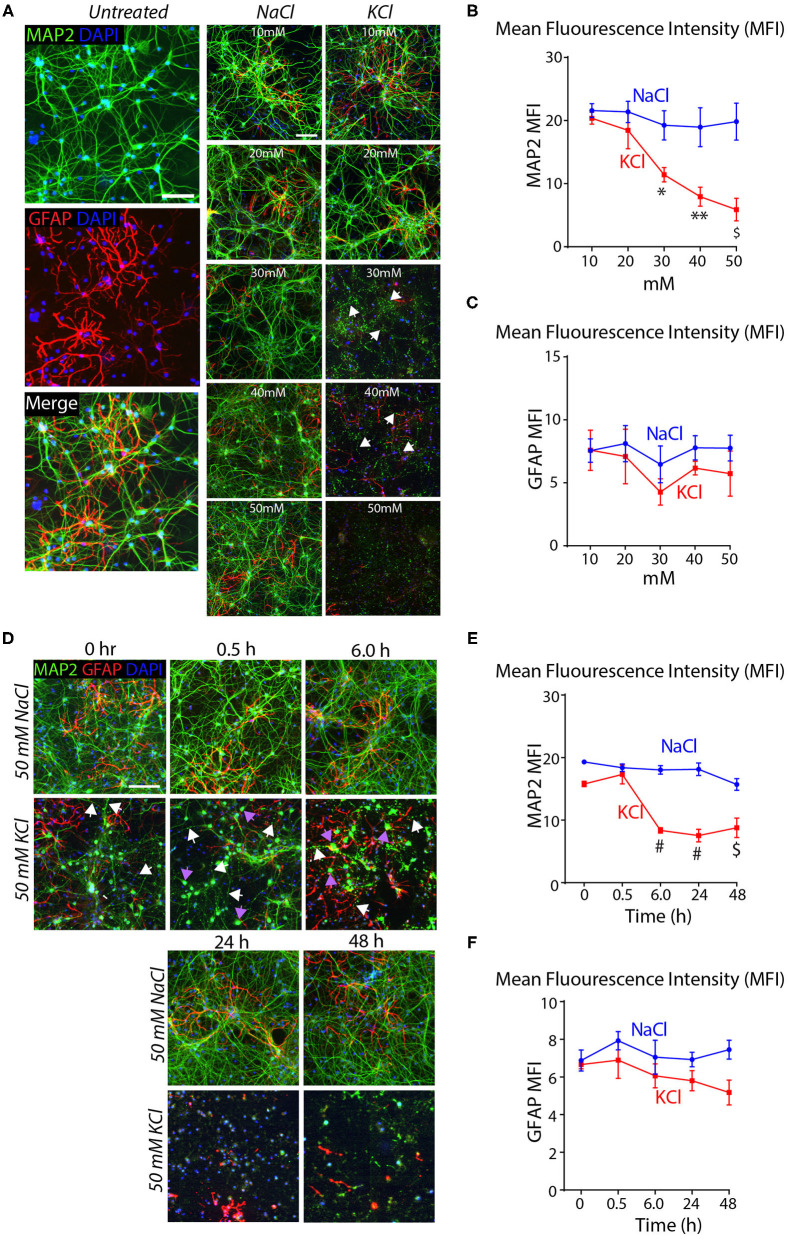
High KCl exposure in cultured cortical neurons leads to reduction in MAP2 protein expression marked by dendritic breakage followed by neuronal death. (A) Representative microscopic images of NaCl and KCl treated neurons at different concentrations show remarkable reduction in MAP2 levels from 30 mM KCl and almost no signal at 50 mM. Arrows indicate dendritic breakage. GFAP levels remains the stable across all concentration of KCl and NaCl. Untreated cells shown for comparison. (B,C) Quantification of mean fluorescence intensity (MFI) of MAP2 and GFAP immunofluorescence show gradual and significant reduction in MAP2 levels from 30 to 50 mM to KCl compared to NaCl treated cells. (* = p 0.0225, ** = p 0.0016, $ = p 0.0004) (B). GFAP levels show no significant difference across various NaCl and KCl concentrations (C). (D) Representative microscopic images of 50 mM NaCl and KCl treated neurons collected at different time points show notable staining pattern and reduction in MAP2 levels from as early as 0 h and almost no signal at 48 h. White arrows indicate dendritic breakage and purple arrow indicate mislocalization of MAP2 signals in the cell body. (E,F) MFI quantifications show significant reduction in MAP2 immunofluorescence from 6 to 48 h in KCl treated cultures compared to NaCl and no major difference in GFAP levels in same samples (# = p < 0.0001, $ = p 0.0001). All numerical data are represented as means ± SEM. Statistical significance was calculated by two-way ANOVA using Dunnett's multiple comparison test. Scale bars 100 μm.